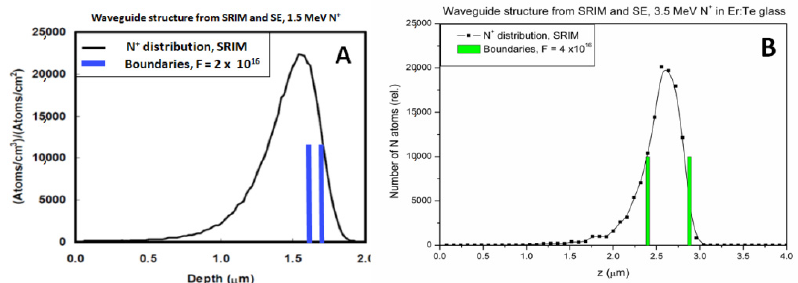
Figure 2. Depth distribution of the N + ions implanted in Er-Te glass calculated with the SRIM code. ( A ). E = 1.5 MeV Blue bars: Boundaries of barrier layer calculated from a spectroscopic ellipsometric (SE) measurement, see Figure 11. Implanted fluence = 2 · 10 16 /cm 2 . ( B ). E = 3.5 MeV. Green bars: Boundaries of barrier layer calculated from a spectroscopic ellipsometric measurement. Implanted fluence = 4 · 10 16 /cm 2 .